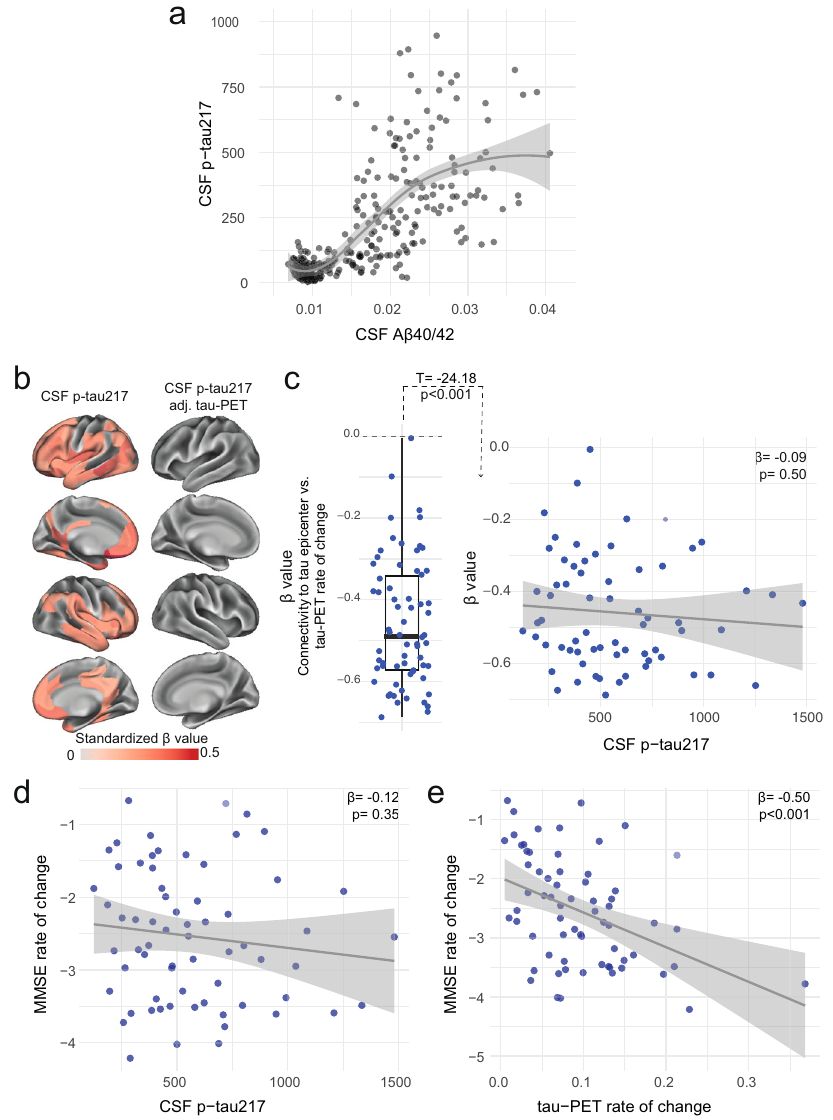
Fig. 5 | Distinct associations between CSF p-tau217 and tau-PET rate of change in the AD dementia stage. a Associations between the ratio of CSF A β 40/42 from Elecsys and CSF p-tau217 across the AD continuum. CSF A β 40/42 is shown here instead of PET to include the entire BioFINDER-2 cohort, since AD dementia patients do not undergo A β -PET. A similar association with A β -PET SUVR is shown in a restricted sample without AD dementia patients in Supplementary Fig. 13. The associationisnonlinearand fl attenathighA β load. b CSFp-tau217alonewasmildly associated with tau-PET rate of change (left column), which was not the case when additionallyadjustingforregionalbaselinetau-PETSUVR(rightcolumn). c Boxplot showing the expected negative β -value from the correlation between tau-PET rate ofchangeandconnectivity-baseddistancetoepicentersacrossallADpatients,but